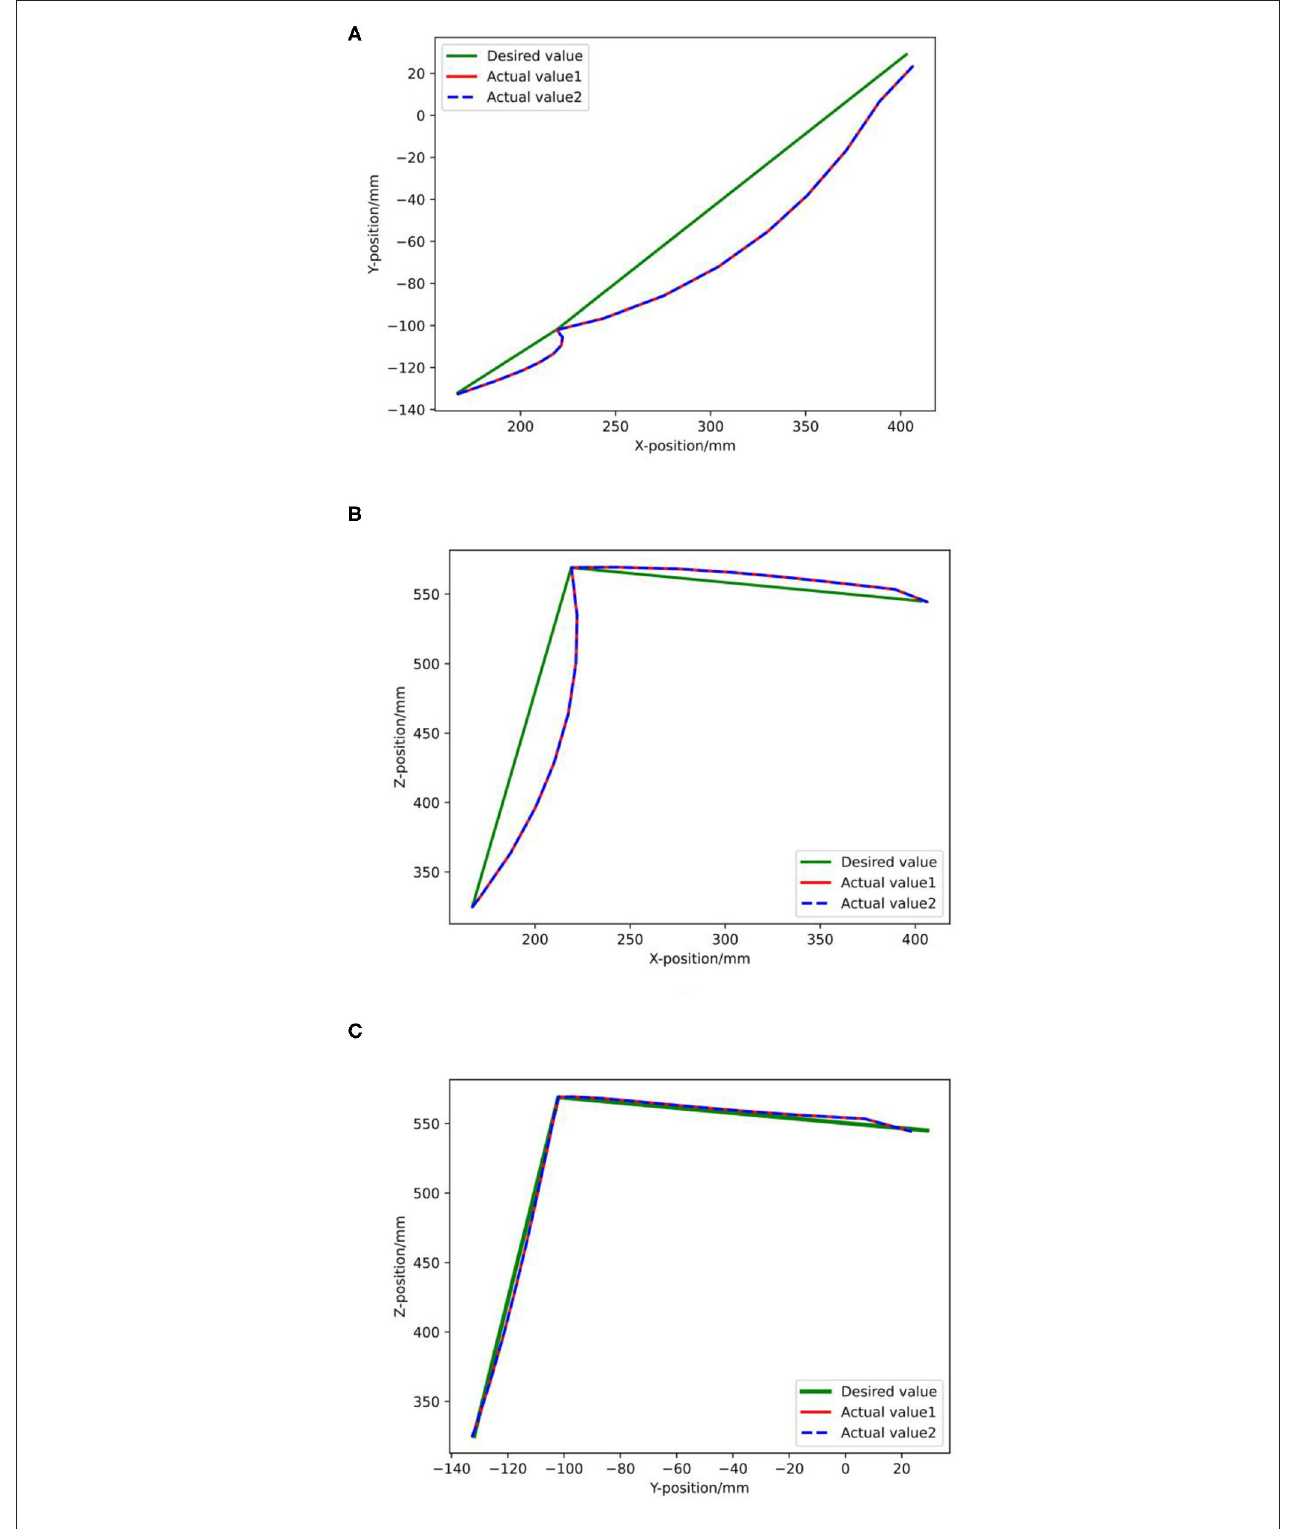
FIGURE 15 | Actual trajectory of the robot in the assembly task in X-Y-Z axes.